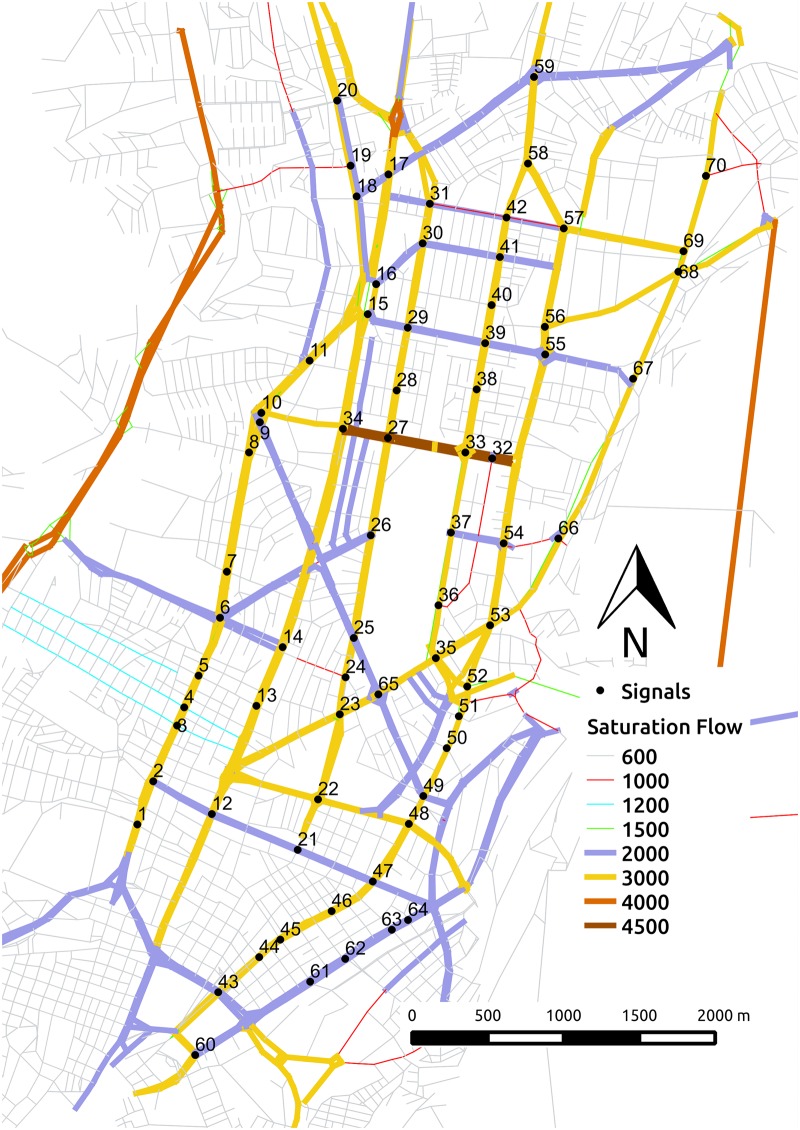
Saturation flows.